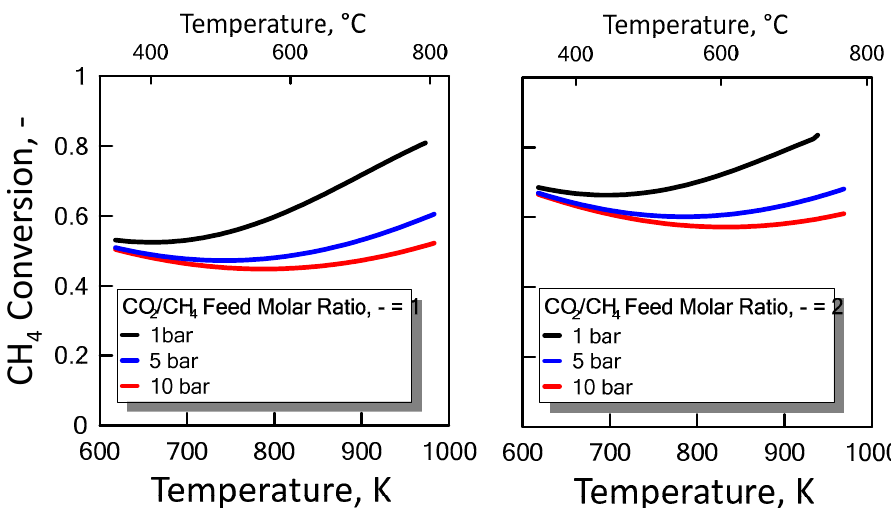
Figure 8. CH 4 equilibrium conversion at CO 2 /CH 4 feed molar ratio of 1 ( left side) and 2 ( right side) as a function of temperature at different pressures taking into account carbon formation.